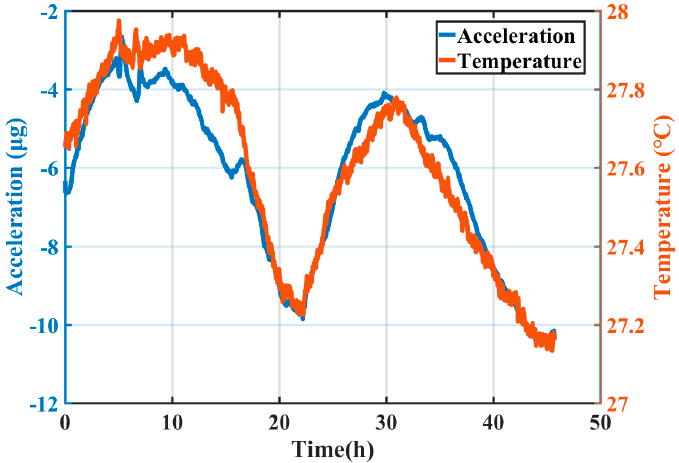
Figure 12. Changes in acceleration output and temperature output over time. Sensors 2020 , 20 , x FOR PEER REVIEW